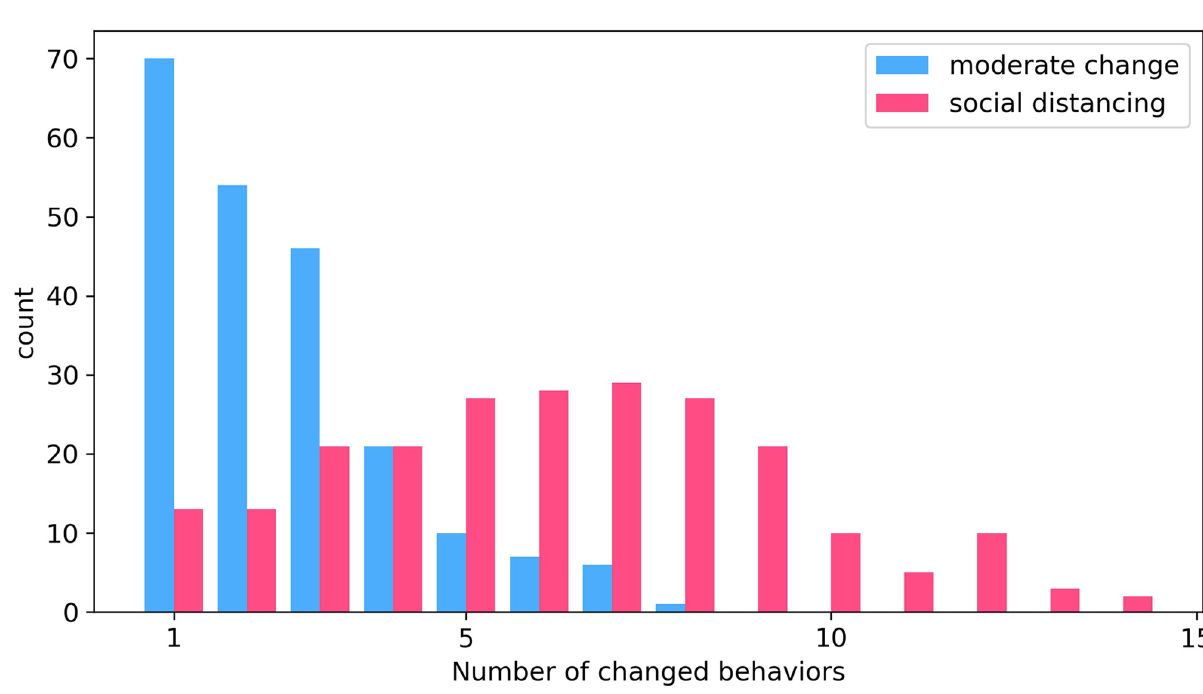
Fig 1. Histograms of number of behaviors changed for the class of social distancing and for class of moderate change . The two histograms look significantly different, with that of social distancing much more skewed towards higher